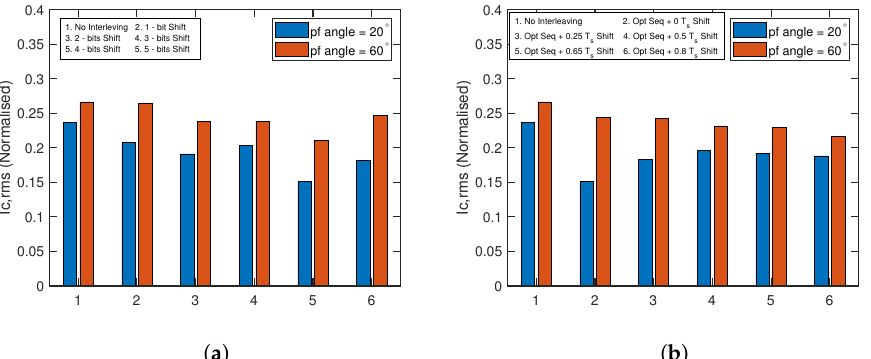
Figure 20. RMS capacitor currents obtained from the hardware results for ( a ) sequence shifts and ( b ) sequence+time